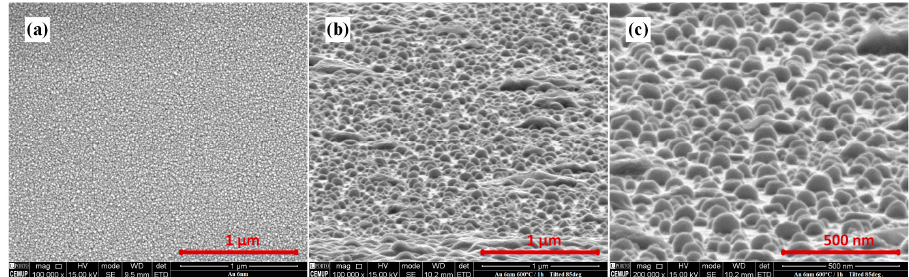
Figure 2. Scanning Electron Microscope (SEM) photograph of a sample coated with 6 nm thick gold thin film: ( a ) before and ( b , c ) after annealing at 600 °C for 1 h.